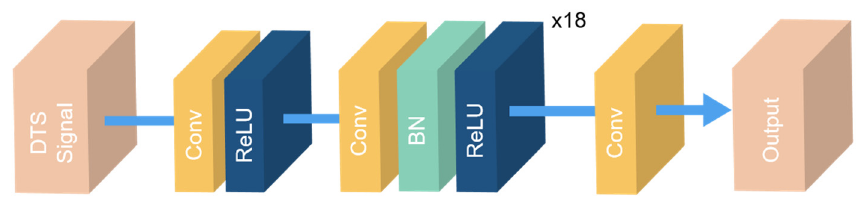
Figure 5. Neural network structure.